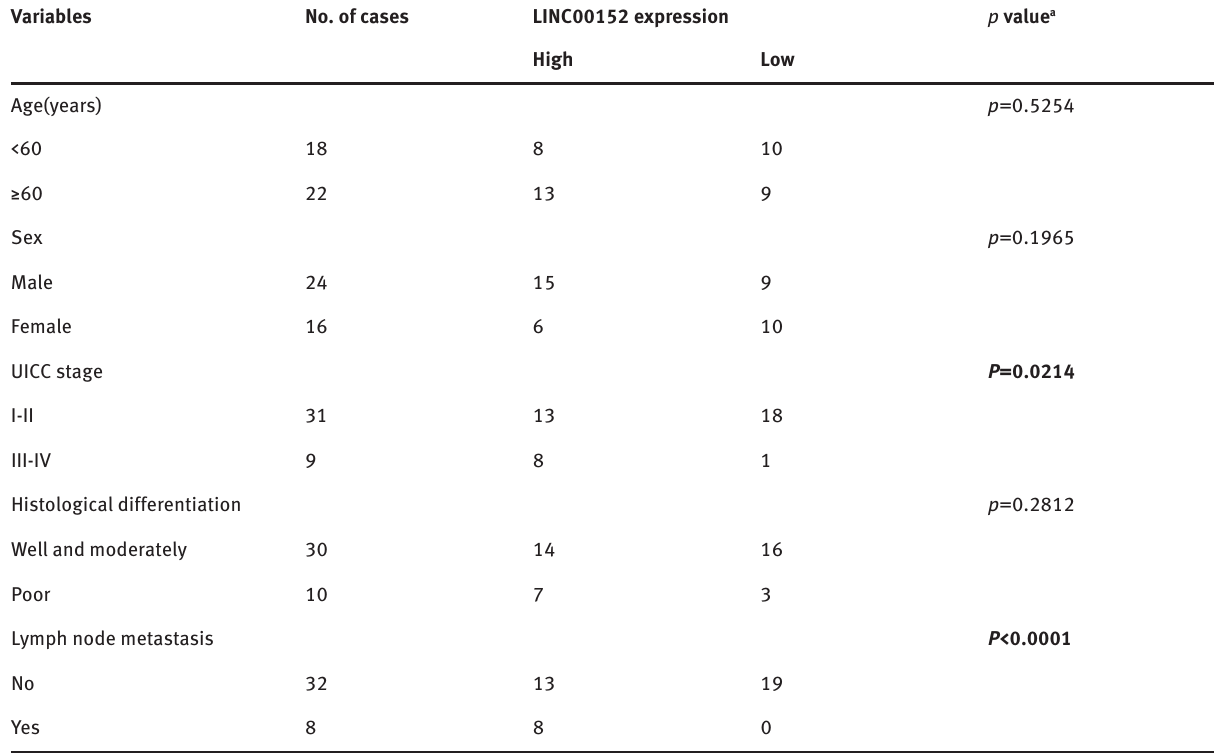
Table 1: Association of LINC00152 expression with clinicopathologic factors in 40 cases of patients with LSCC.